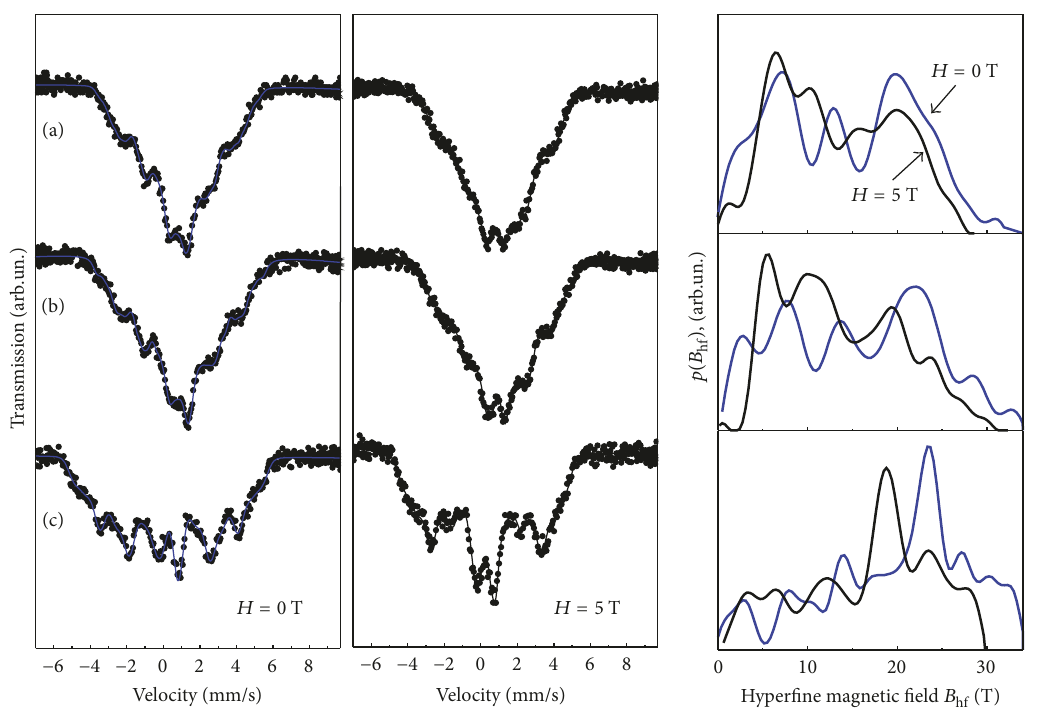
Figure 3: M¨ossbauer spectra and HFF distributions for the alloys: (a) Fe 65 Al 35 , (b) Fe 65 Al 30 Ga 5 , (c) and Fe 65 Al 30 B 5 . M¨ossbauer spectra were measured without external field (left column, dotted line) in an applied external magnetic field 𝐻 ext = 5 T (central column, dotted line). Calculated for HFF distributions p (𝐵 hf ) , M¨ossbauer spectra are represented by solid lines. For HFF distributions p (𝐵 hf ) , blue curve in the right column corresponds to M¨ossbauer spectra measured without external field; black curve in the right column corresponds to the spectra measured in an external magnetic field 𝐻 ext = 5